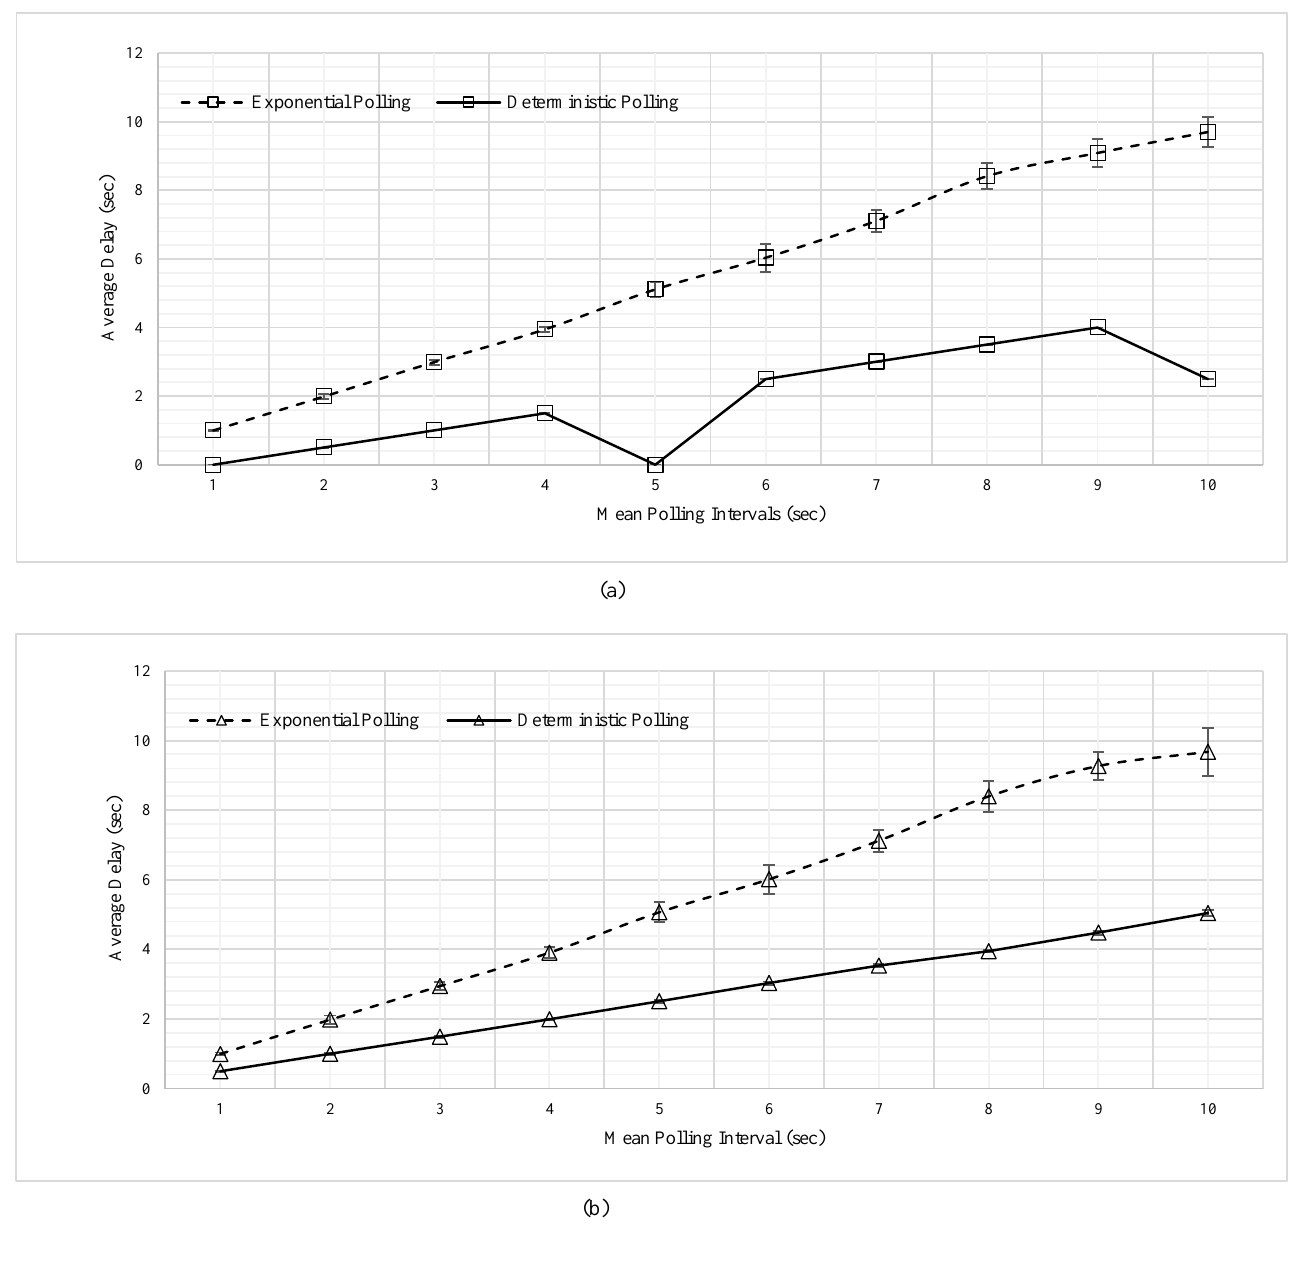
Fig. 3 : High level simulation results for performance evaluation of polling interval distributions (a) CBR arrivals (b) Poisson